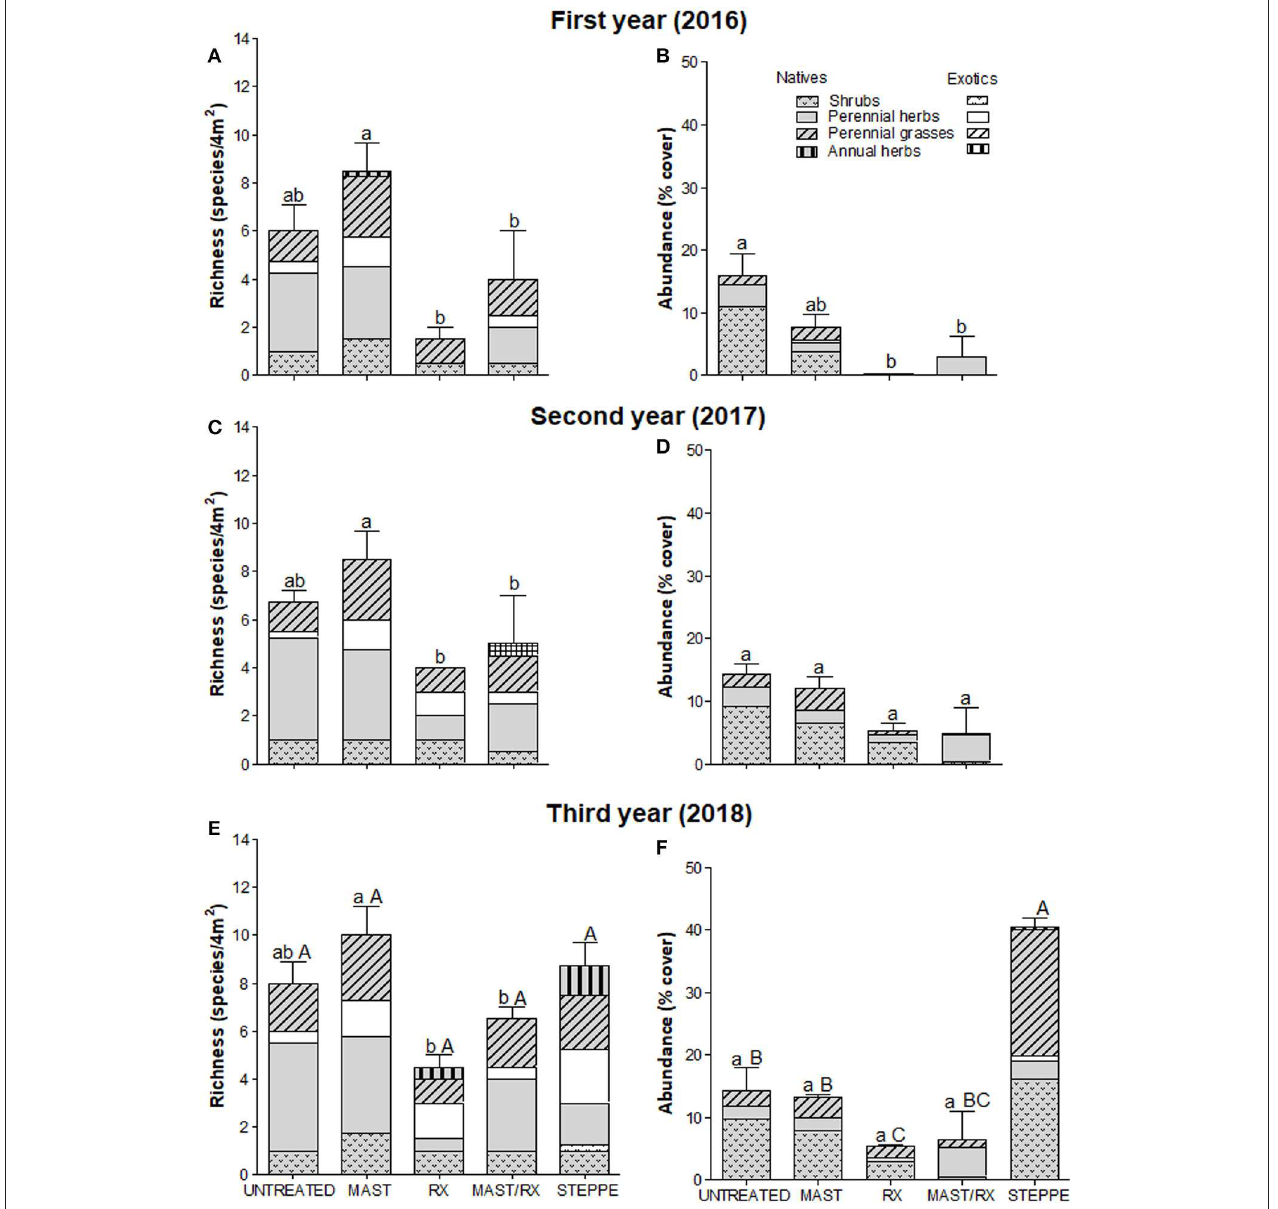
FIGURE 4 | Vegetation richness (A,C,E) and abundance (B,D,F) by origin and growth form in each fuel treatment for the first (A,B) , the second (C,D) , and the third (E,F) years; steppe vegetation variables are included for the third year in site 1. Bars indicate total richness and abundance SE , respectively. Different small letters indicate differences among fuel treatments for each year (differences among years for each fuel treatment are not represented), and capital letters indicate differences among fuel treatments and steppe. Treatments are as follows: residues on the floor (UNTREATED), mastication (MAST), prescribed fire (RX), mastication plus prescribed fire (MAST/RX), and steppe vegetation